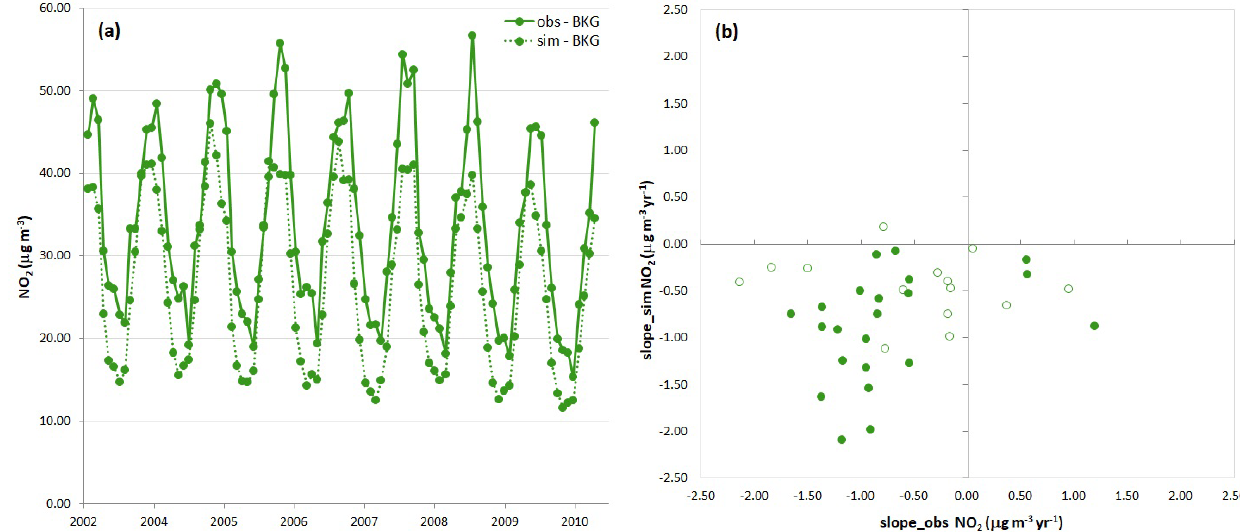
Figure 4. (a) Observed (solid line) and simulated (dashed line) monthly means of NO 2 concentrations (in µgm − 3 ) for all the background monitoring stations. (b) Scatter plot of observed and simulated slopes (in µgm − 3 yr − 1 ) at each individual station. Sites where significant slopes are estimated for both observations and simulated data are indicated with a filled symbol.